Question: Condense the content of this figure into a single sentence.
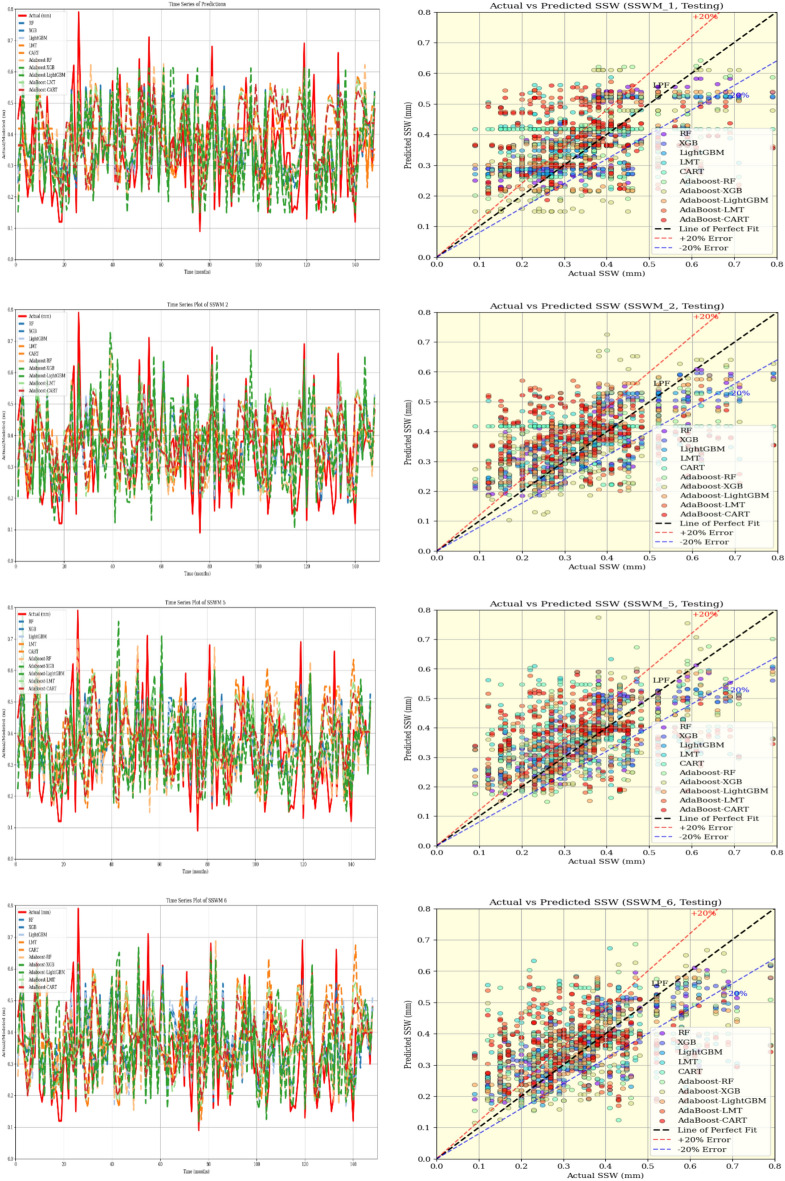
Answer: Time series plot of observed and predicted models and scatter plot between actual and predicted SSW of the Hoshiarpur during testing of the models.